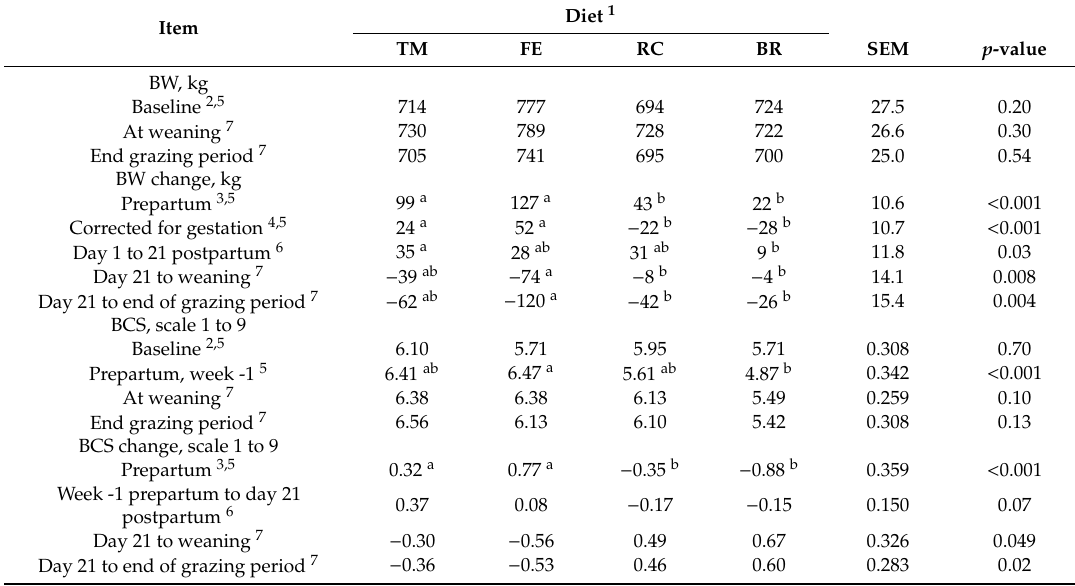
Table 3. E ff ect of prepartum experimental diet on cow body weight (BW) and body condition score (BCS) in beef cows pre- and postpartum.